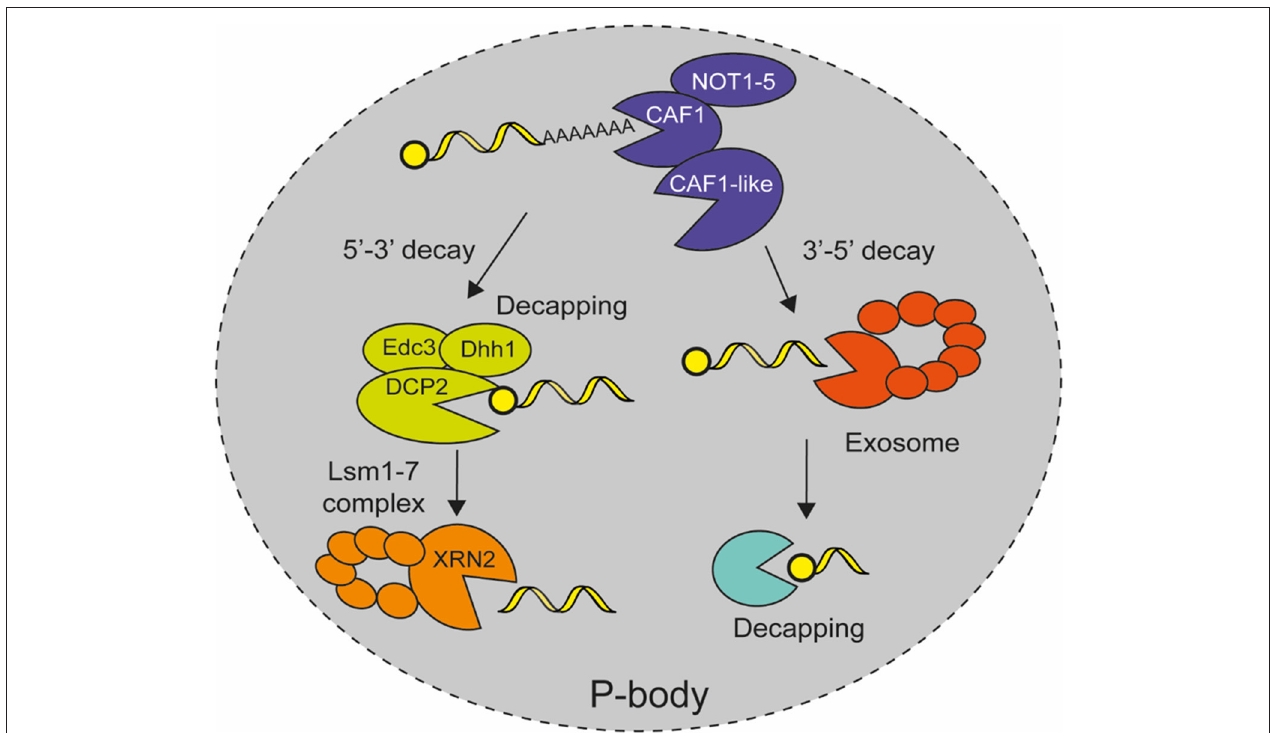
FIGURE 3 | Model for mRNA decay in E. histolytica . After mature mRNAs are exported to the cytoplasm where they are eventually translated in a regulated manner, they are later degraded in cytoplasmic P-bodies like structures. The mRNA degradation pathway starts with transcript deadenylation by the CAF1/NOT complex. Then, DCP2 mRNA decapping enzyme removes the cap structure from the 5 ′ end of the mRNA with the help of accessories proteins Edc3 and Dhh1, which allows 5 ′ -3 ′ exoribonuclease XRN2 with Lsm protein complex to degrade the rest of mRNA body. Alternatively, the deadenylated transcript is degraded in a 3 ′ -5 ′ direction by the catalytic subunit Dis3 of the exosome complex and the cap structure is eliminated by DCPs protein ( López-Rosas et al., 2012, 2014).